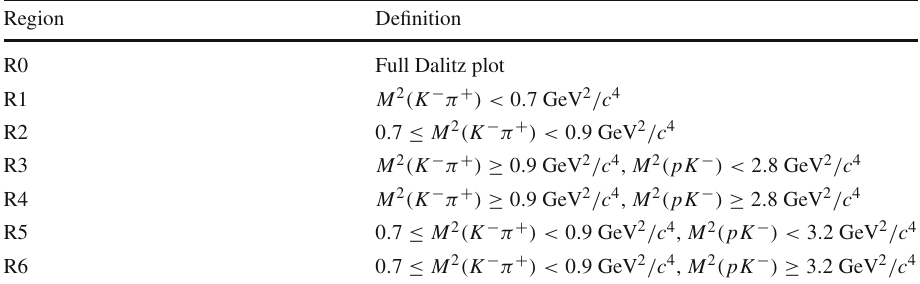
Table 2 Definitions of the Dalitz plot regions for Ξ + → pK − π + decays c